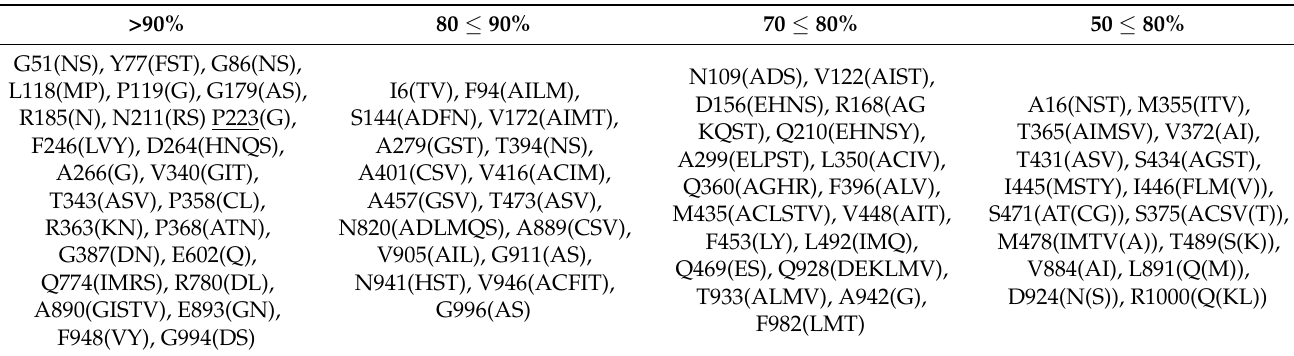
Table 3. Additional highly conserved